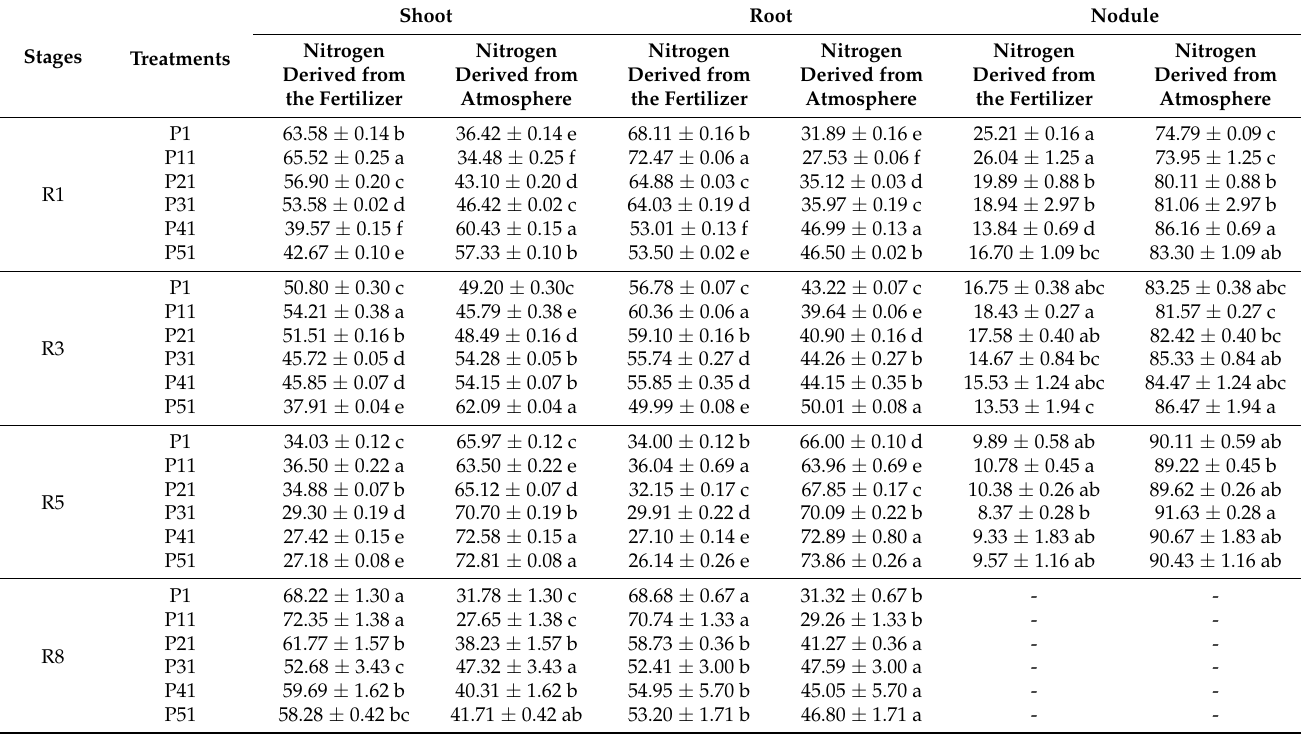
Table 4. The proportion of nitrogen sources in different parts of soybean under different phosphorus supply levels